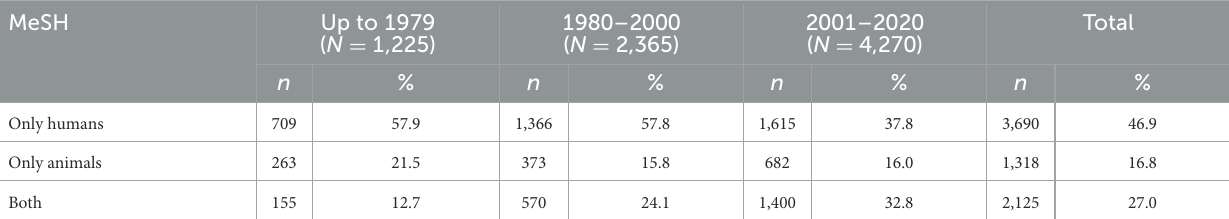
TABLE 5 Documents on cysticercosis and neurocysticercosis assigned MeSH descriptors for research in humans and animals and indexed in MEDLINE.